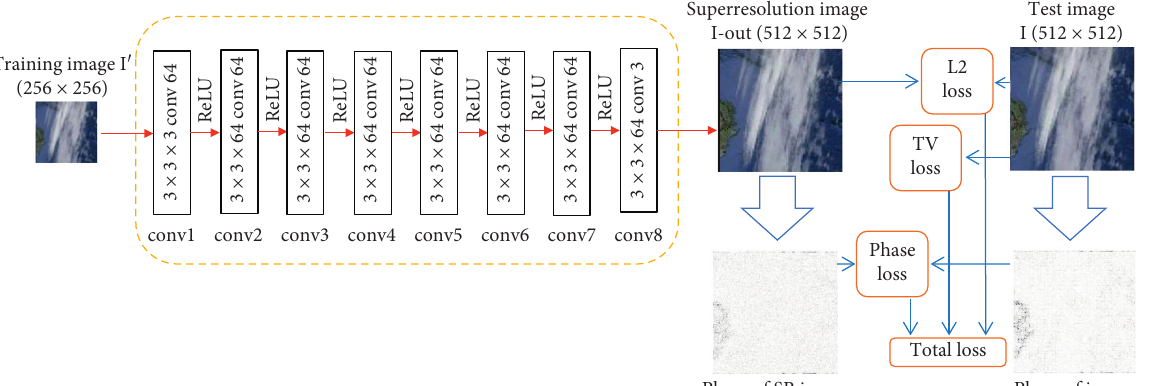
Figure 2: The architecture of MSLp superresolution framework. On the left, a low-resolution image obtained by its real image with the estimated blur kernel is fed to the network to produce a superresolution image, which is then passed to the total loss function combined with spatial and frequency loss to measure the difference between the generated image and the target